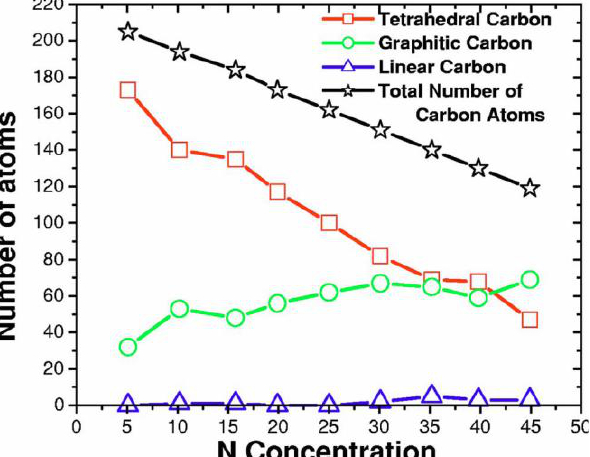
Figure 13. The bonding nature of carbon is shown as a function of nitrogen concentration. The tetrahedral carbons (squares) decrease whereas the graphitic carbons (circles) increase as the nitrogen concentration increases.